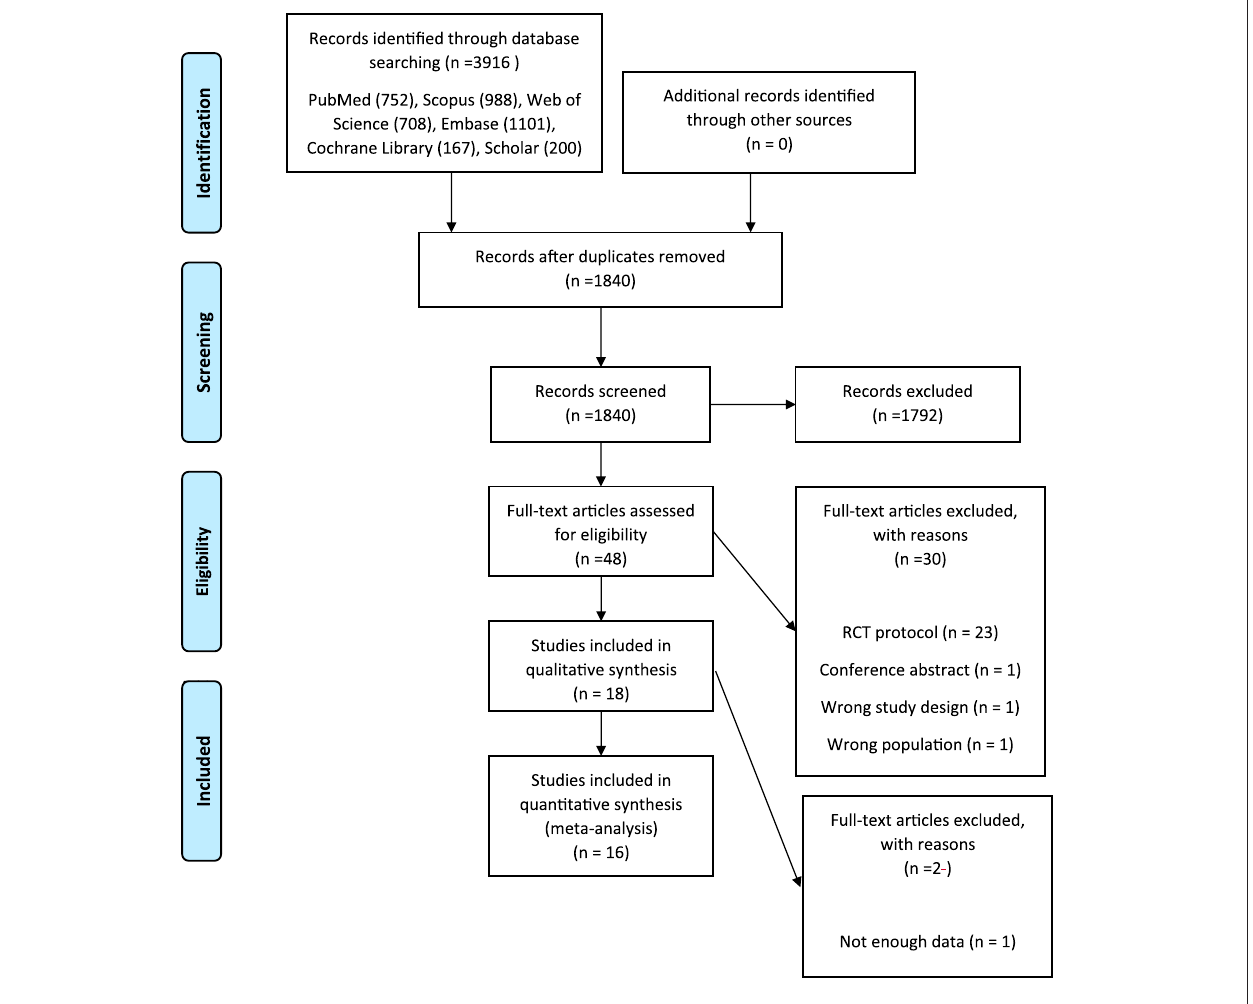
FIGURE 1 | Flow chart of the literature search strategy and study